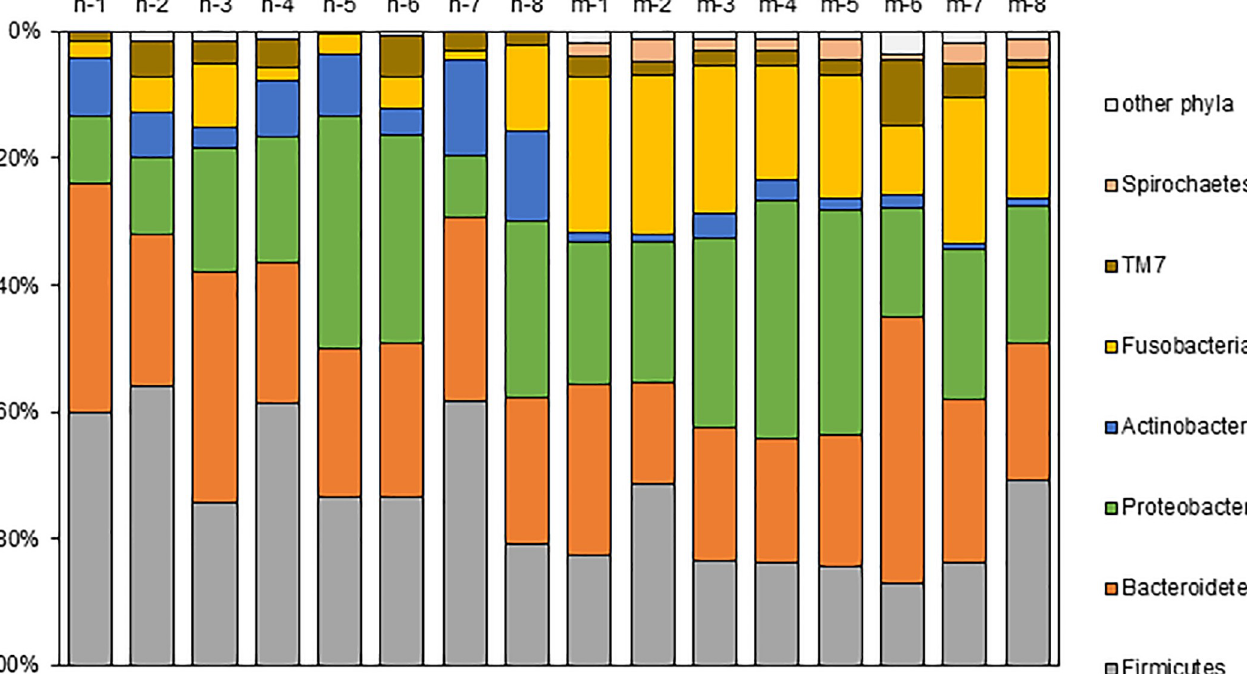
Fig 3. Microbial composition at the phylum level. Samples are represented along the horizontal axis, and relative abundance is denoted by the vertical axis. h-1 – h-8: human, m-1 –m-8: marmoset.